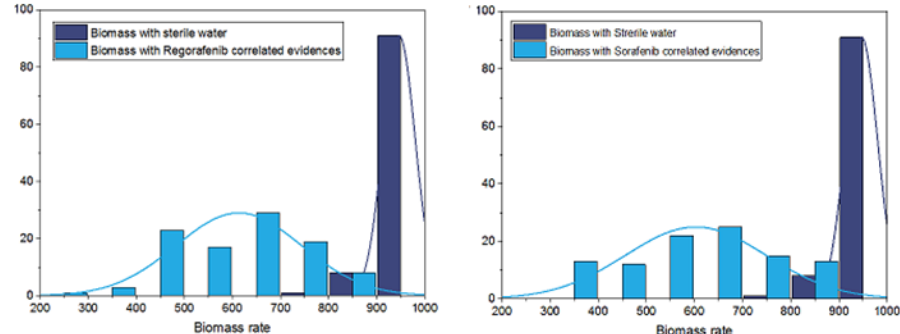
Figure 4. Comparison between predicted Hepatocellular Carcinoma (HCC) tumor cell growth rates obtained under sterile water and those under Sorafenib and Regorafenib drugs with an evidence set that contains known drug targets and genes that correlate with them.